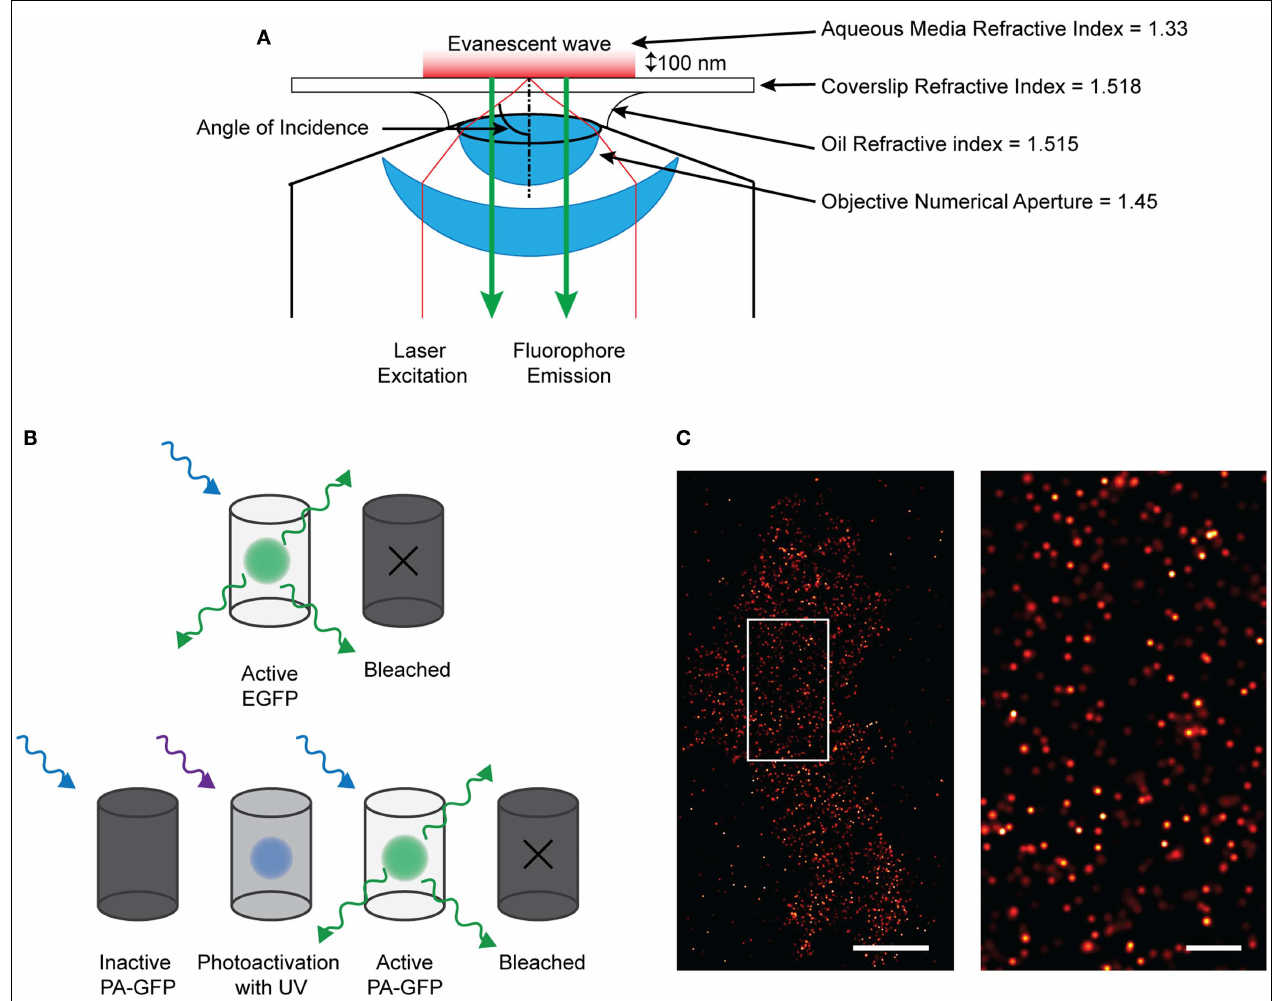
emit fluorescence which can be detected. (B) Demonstrating the difference between EGFP and PA-GFP. EGFP will absorb and emit light without prior activation before bleaching off. PA-GFP needs to be activated by short-wavelength light before it is confirmationally able to absorb excitation and emit light. (C) (left) Localized and rendered PALM image of BK channels on the plasma membrane of a HEK293 cell (scale bar: 5 µ m) with a region of interest (right) showing the localization of molecules in detail (scale bar: 1 µ m).